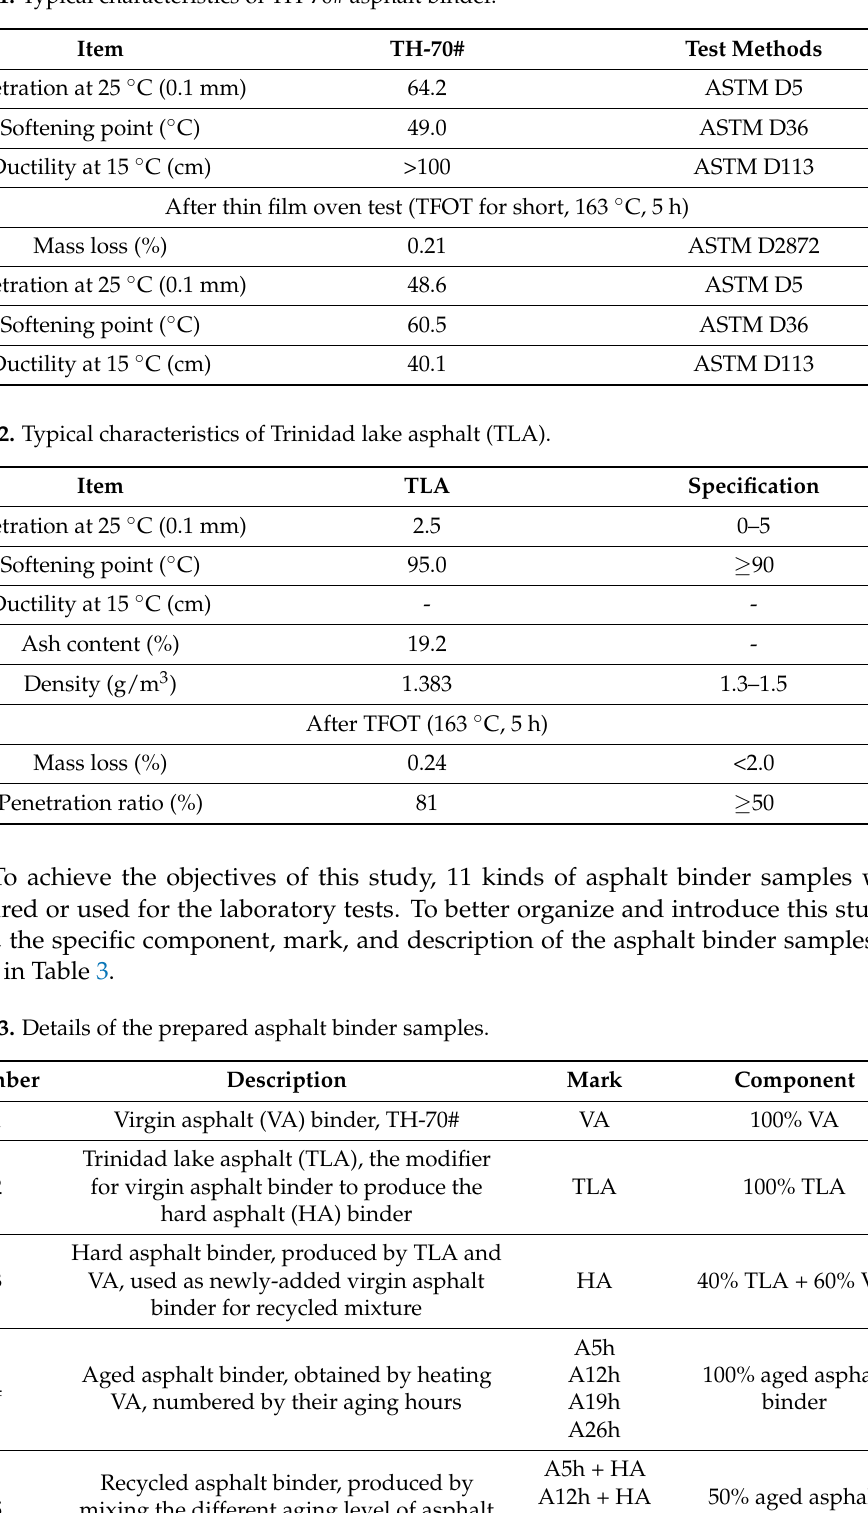
Table 1. Typical characteristics of TH-70# asphalt binder.